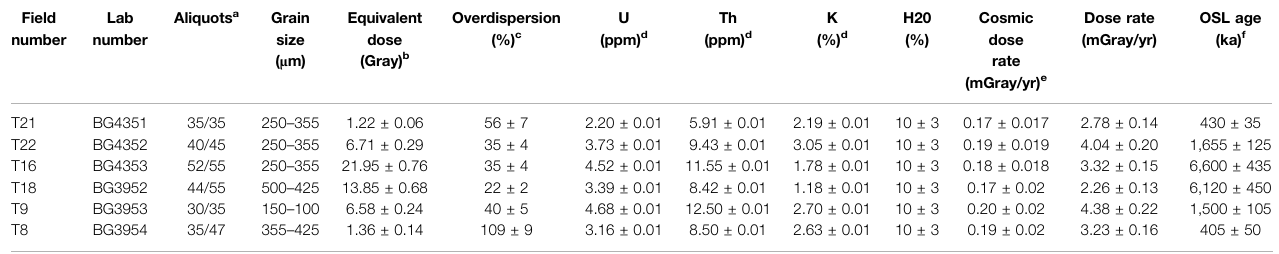
TABLE 1 | Optically stimulated luminescence (OSL) ages on quartz grains from fl uvial deposits, Tecpan River, western